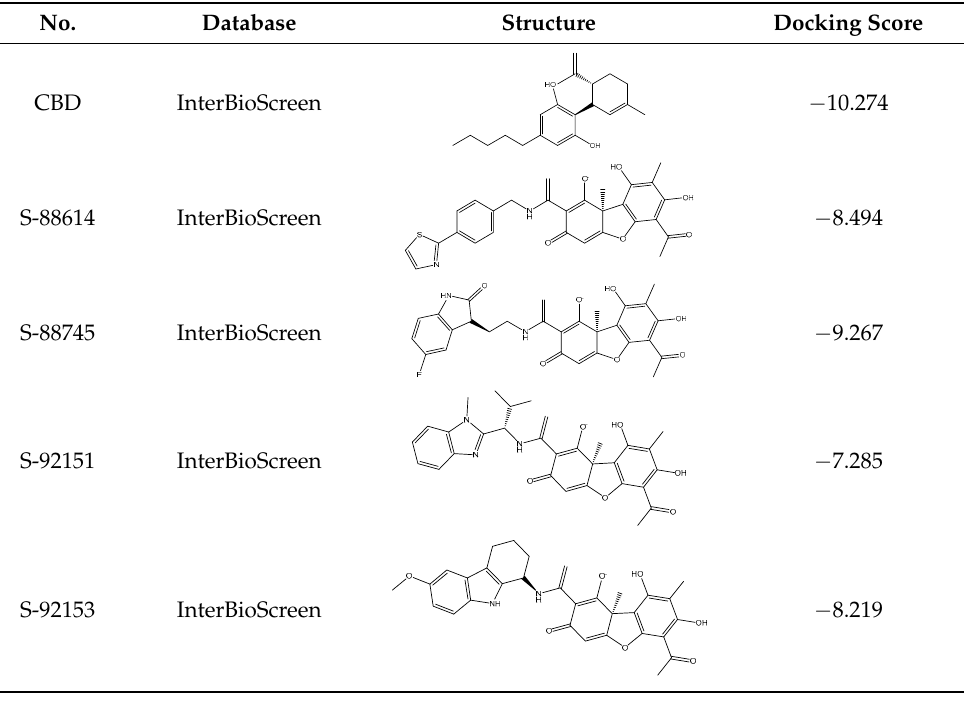
Table 1. The molecular structures and docking scores of CBD and the selected compounds, by virtual screening.